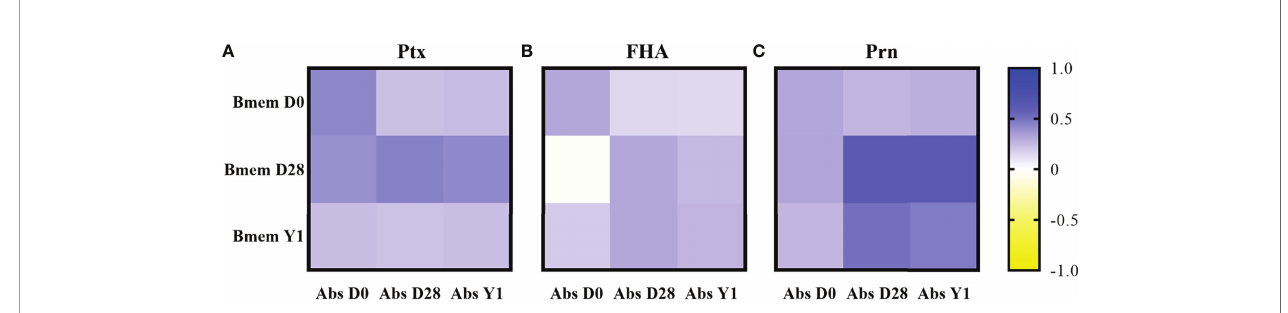
FIGURE 4 | Correlations between memory B cell frequencies and antibody concentrations presented as heatmaps per antigen for all participants together based on Pearsons ’ correlation on the log10 transformed memory B cell frequencies and antibody concentrations. Ptx: pertussis toxin; FHA, fi lamentous haemagglutinin; Prn, pertactin; Bmem, memory B cell frequencies; Abs, antibody concentrations; D0: day 0 (baseline); D28, day 28 post-vaccination; Y1, 1 year post-vaccination. Correlations for (A) pertussis toxin; (B) fi lamentous haemagglutinin; and (C) pertactin.